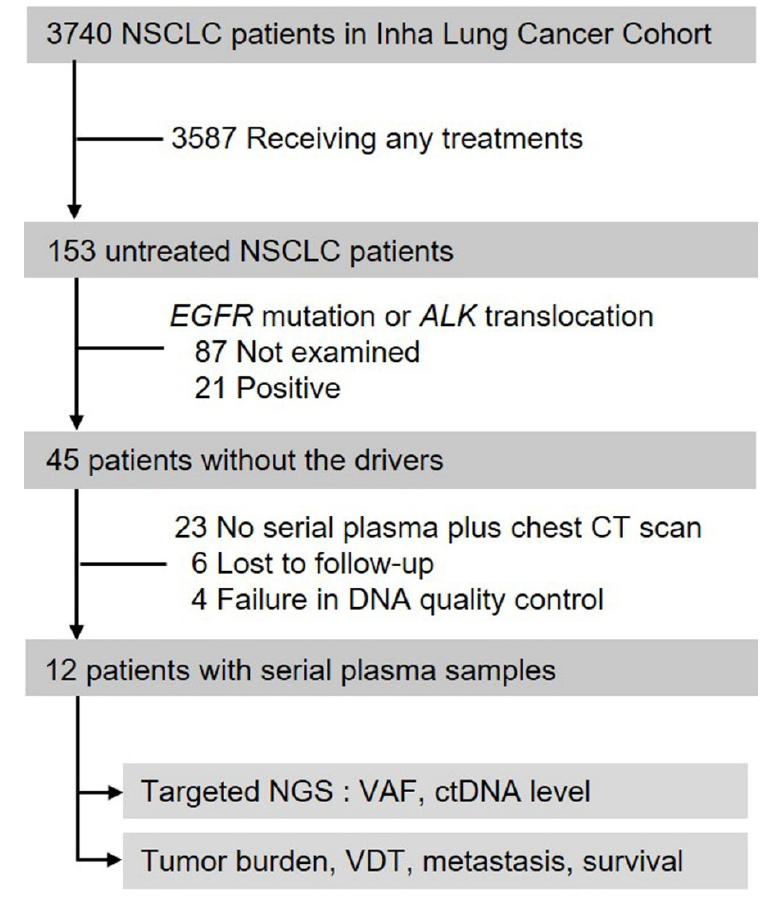
Figure 5. Flowchart of patient selection. NSCLC, non-small cell lung cancer; EGFR, epidermal growth factor receptor; ALK, anaplastic lymphoma kinase; CT, computed tomography; NGS, next- generation sequencing; VAF, variant allele frequency; hGE, haploid genome equivalent; VDT, volume doubling time.